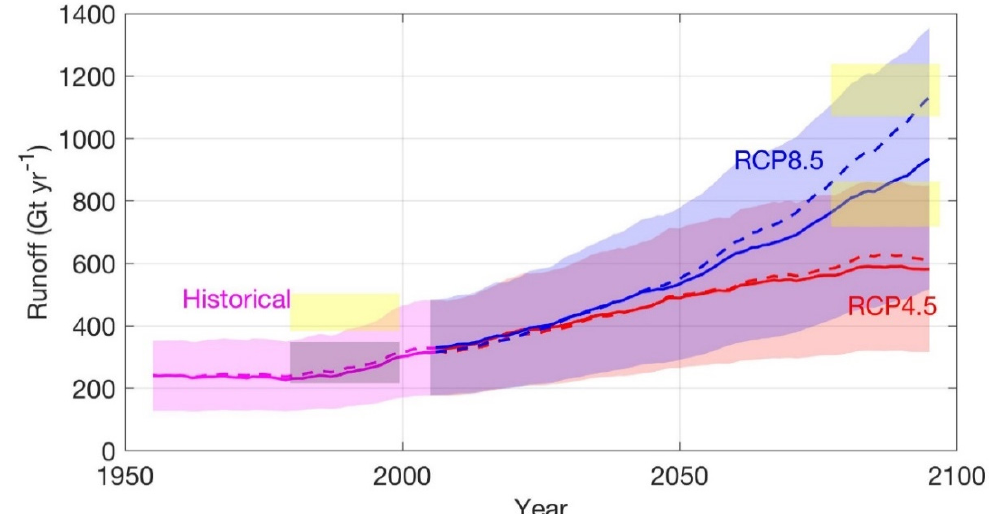
Figure 6. Decadal GrIS runoff estimated by the average of two DD models (solid lines) and SEMIC (dashed lines) during 1950–2100 under historical (magenta), RCP4.5 (red), and RCP8.5 (blue) scenarios. Both SEMIC (mean of 8 albedo parameterizations) and DD results are driven by five ESMs. Colored shadings indicate the results spread in different DDF values. The grey boxed region is from MAR model results (Fettweis et al. [18]); the yellow boxed regions are from Vizcaino et al. [54].